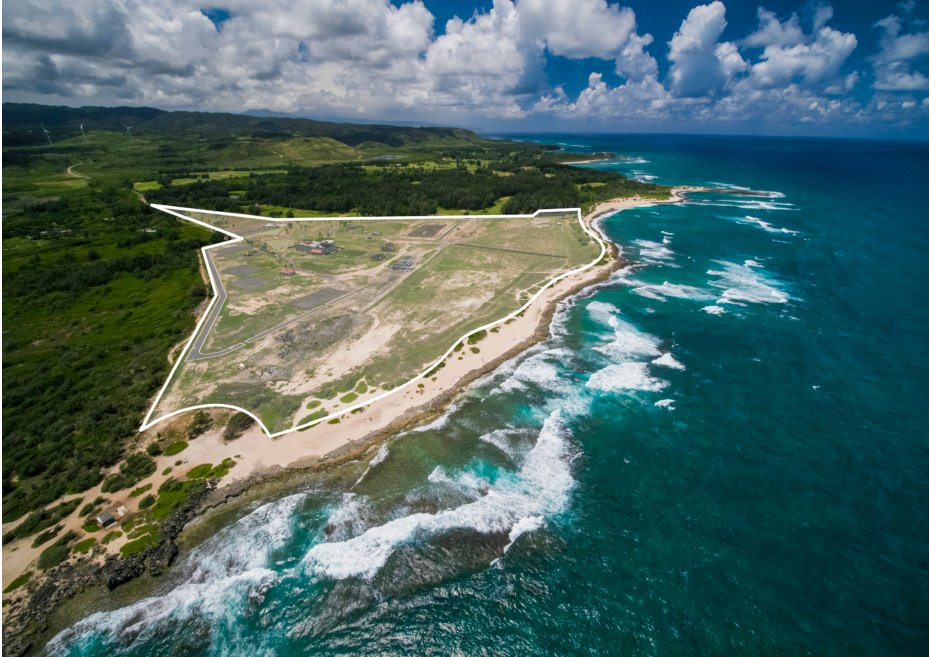
Figure 2.2: Promotional images of Marconi Farms housing development, Kahuku, O‘ahu, Hawai‘i. Author’s screen